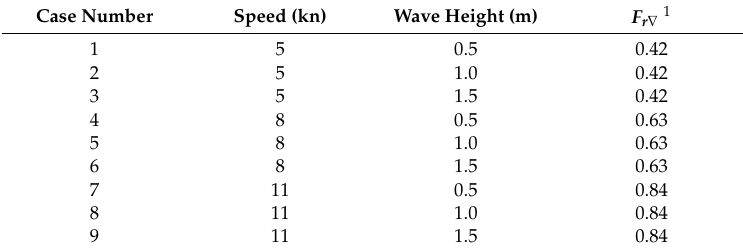
Table 2. Cases Table 2. Cases list.